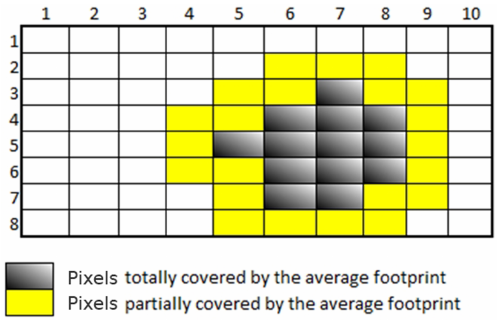
Figure 3. MODIS pixels partially or totally covered by XLAS source